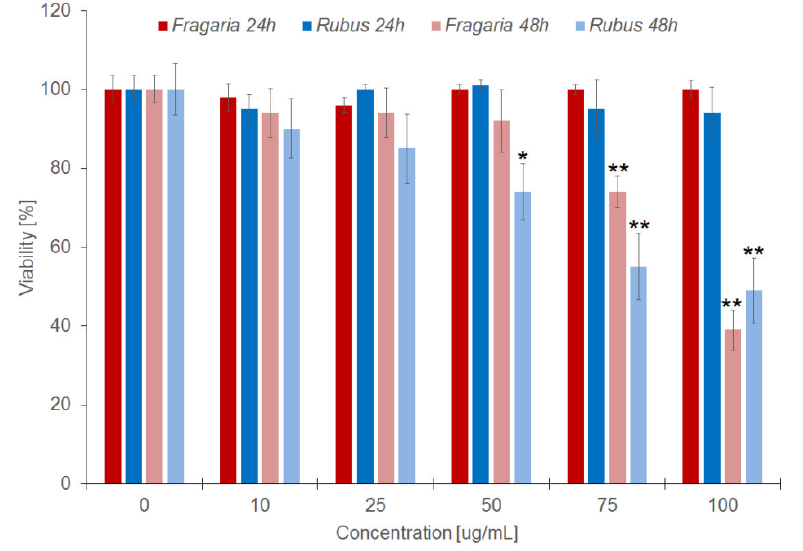
Figure 1. The percent of viability in cells modified by Fragaria and Rubus extracts after 24 h (grey bars) and 48 h (black bars) of incubation, calculated on the basis of MTT assay results. Statistically significant differences between modified and control cells are marked: * α = 0.05; ** α =